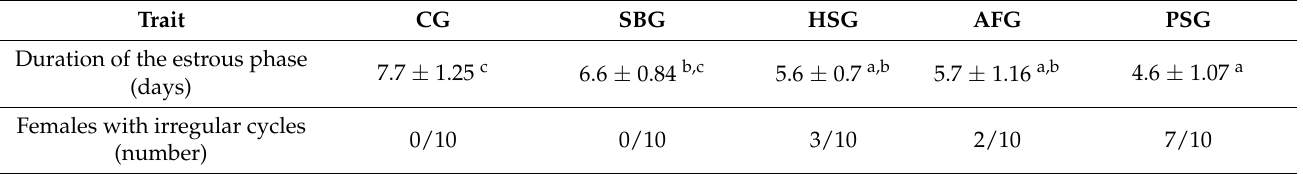
Table 2. Summary of the estrous cycles in the females